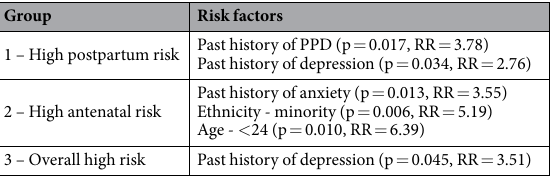
Table 3. Relative Risk (RR) values for significant variables within each at risk